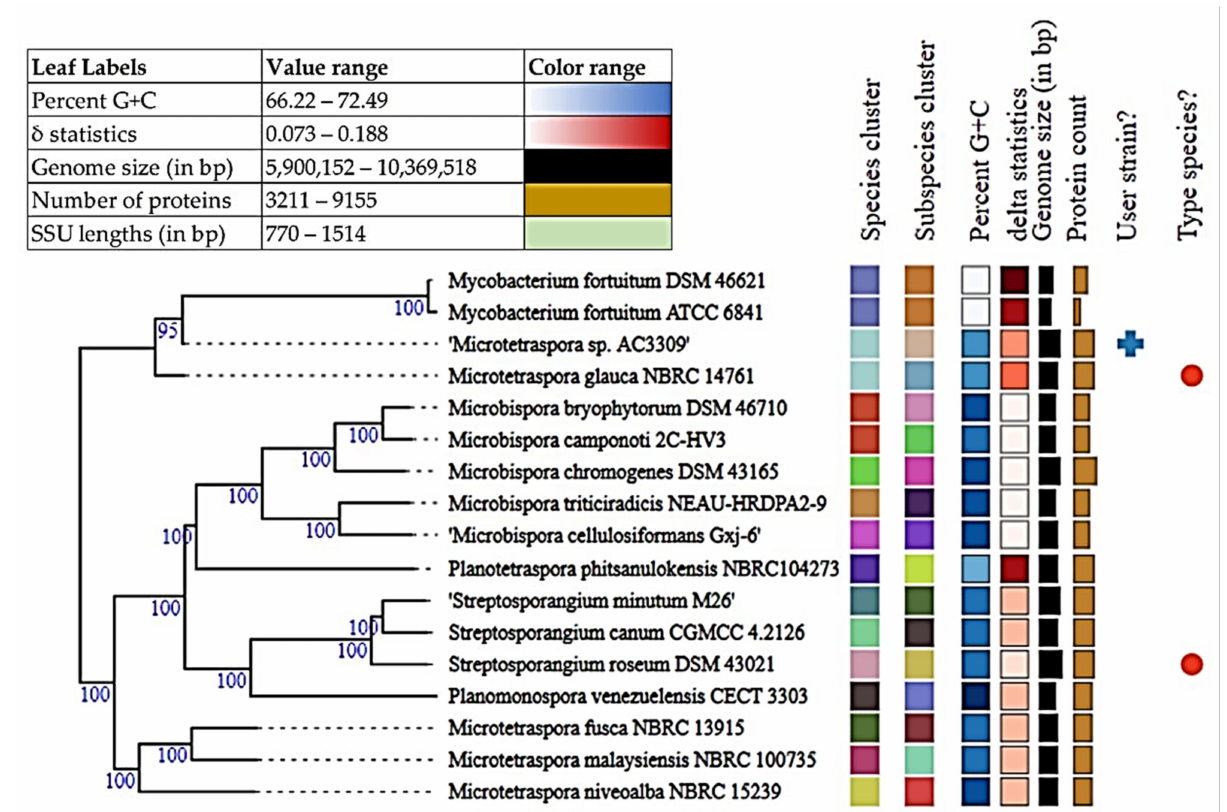
Figure 2. Tree inferred with FastME 2.1.6.1 (Lefort et al., 2015) from GBDP distances calculated from genome sequences. The branch lengths are scaled in terms of GBDP distance formula d5. The numbers above branches are GBDP pseudo- bootstrap support values > 60% from 100 replications, with an average branch support of 100%. The tree was rooted at the midpoint